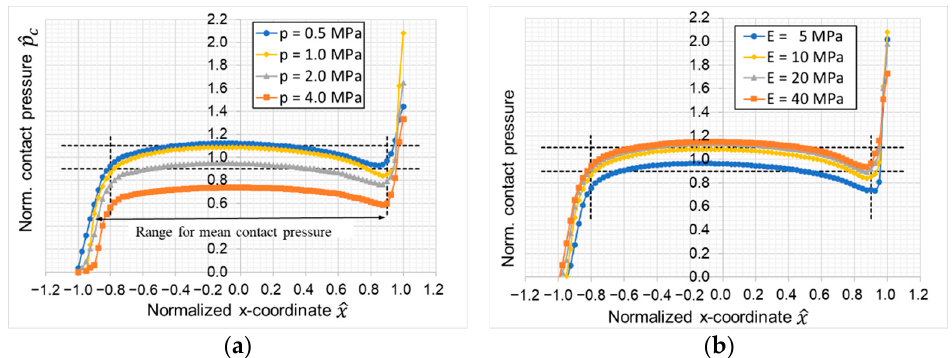
Figure 9. Influence of ( a ) nominal load and ( b ) Young’s modulus of the polymer.